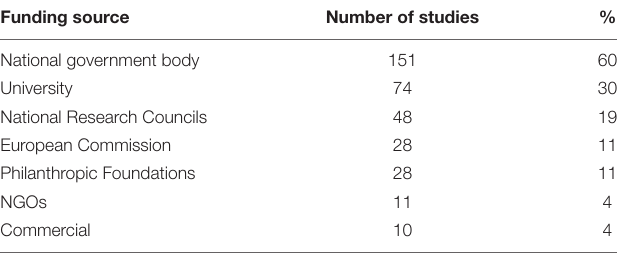
TABLE 3 | Funders supporting marine public perceptions studies ( n = 250).